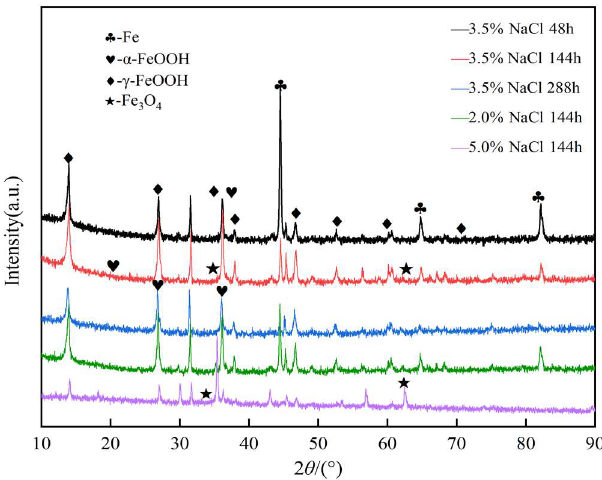
Figure 4. XRD patterns of the rust layers of ER8 wheel steel.